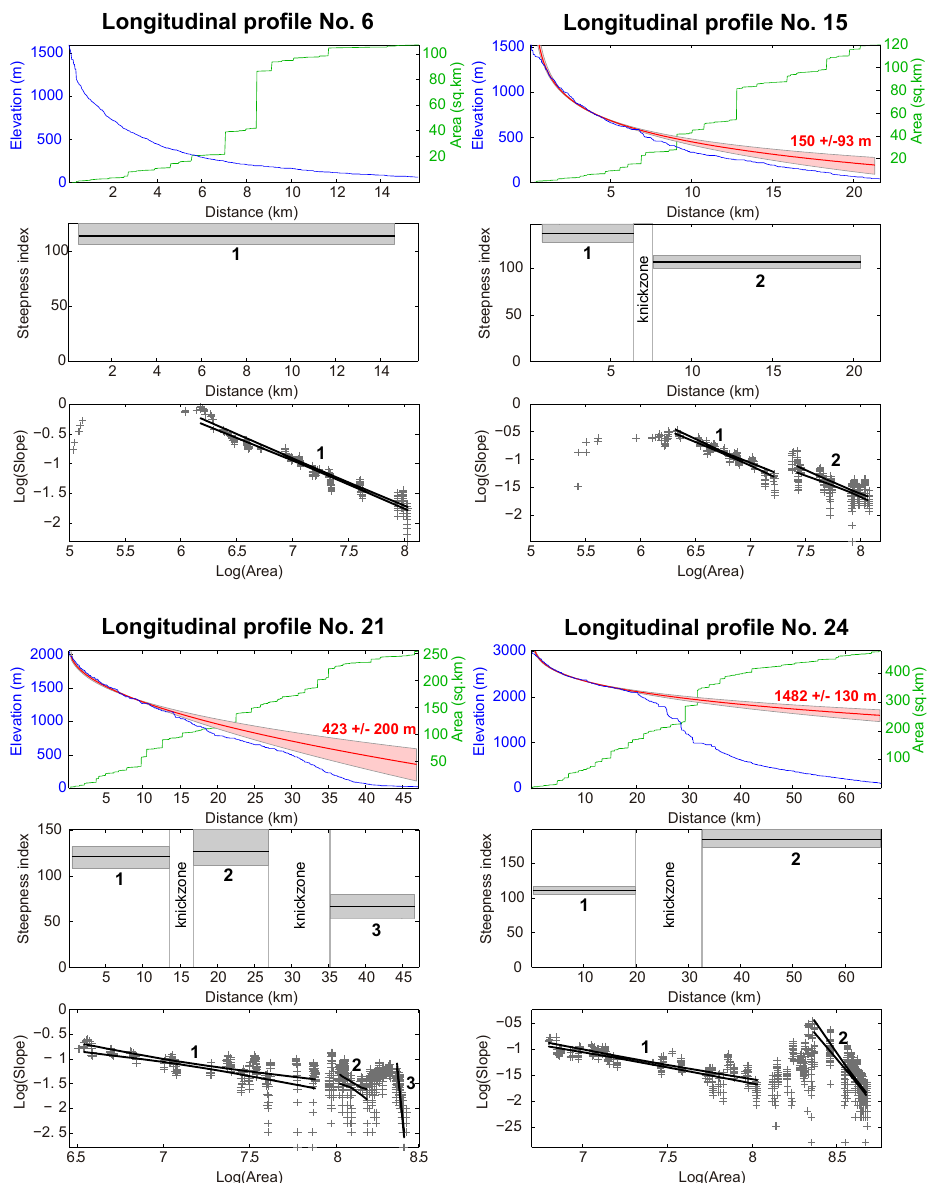
Figure 12. Examples of stream profiles extracted from the modeled drainage network in Chiapas Massif and volcanic arc. Upper plots: blue lines represent longitudinal profiles, green lines show the contributing area (flow accumulation), red lines show reconstructed profiles (interpolation of the slope–distance relation from segments above the upper knickzones; see Eq. 7) and pink polygons represent the uncer- tainties (based on a bootstrapping method). Central plots: black lines represent extracted steepness index ( k sn ) values for a given segment and grey polygons show the uncertainties (based on a bootstrapping method). Lower plots: logarithmic plots of slope vs. area (grey crosses) and envelopes of regressions (black lines) used to estimate the k sn